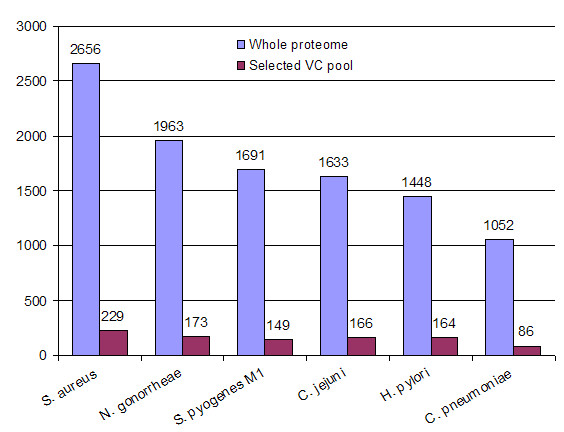
Data concerning the six proteomes used to test NERVE settings. The number of selected VCs is reported beside the overall number of sequences. Average size of selected VCs pools is 9.32% of proteome (min 8,17%, max 11,33%).